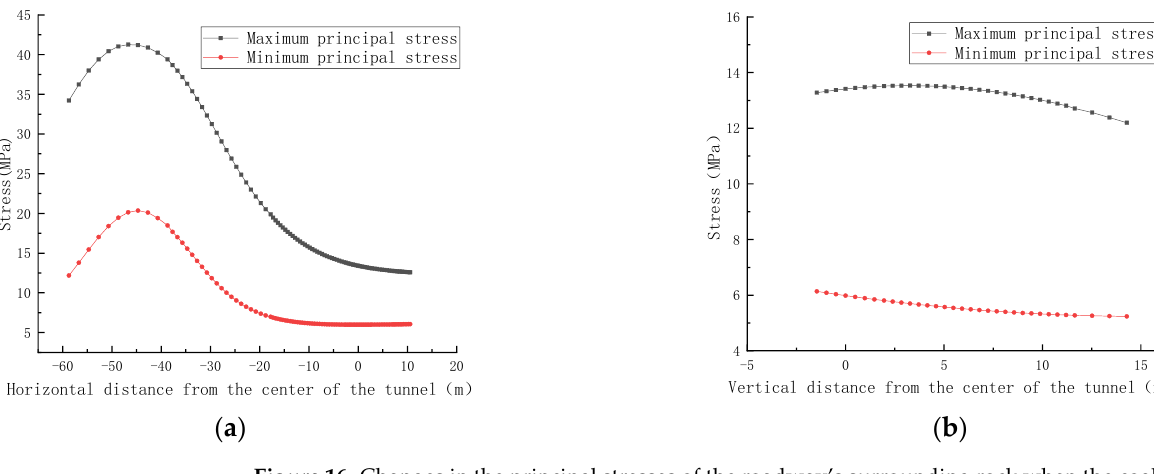
Figure 16. Changes in the principal stresses of the roadway’s surrounding rock when the coal column is 4 m. ( a ) Horizontal direction. ( b ) Variation direction. According to the plastic zone distribution cloud map (Figure 17), the maximum damage depth of the roadway plastic zone is 3 m. The range is small and is mainly distributed in the top plate and two gang positions. The bottom side has almost no plastic zone distributions, the roadway plastic zone in an independent state.